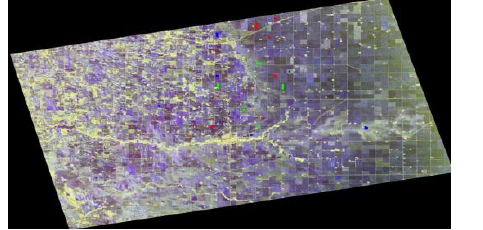
Figure 1. Pauli Image of RADARSAT-2 acquired in April 16, 2012 in FQ2W mode, where crop regions of interest are overlaid. Red: Canola; Green: Corn; Blue: Wheat